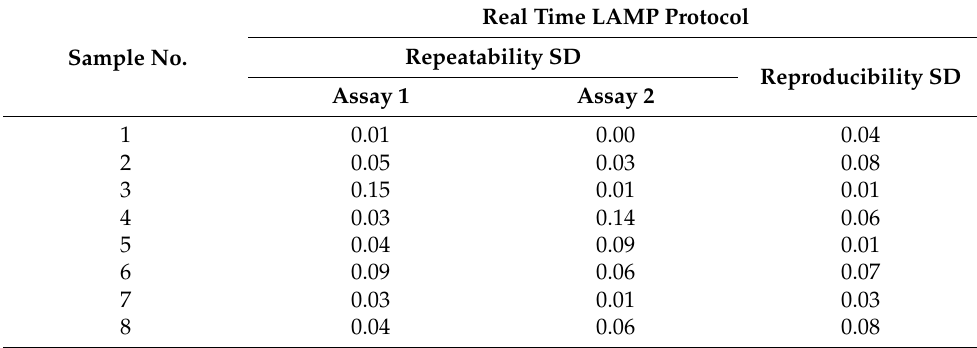
Table 1. Repeatability and reproducibility of real time LAMP assay on frass measured as standard deviation